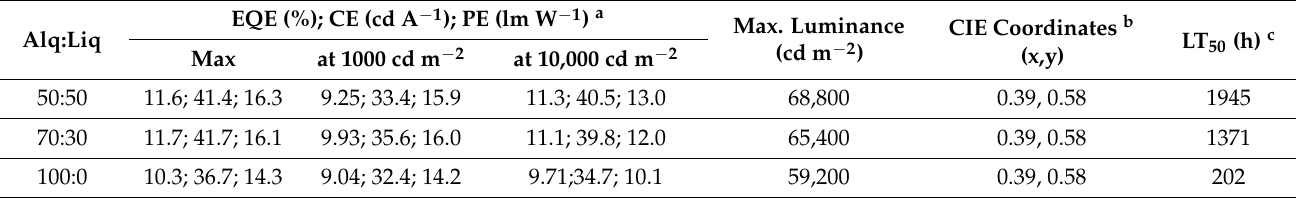
Table 1. Key performances of tetra-Pt-S-based PhOLEDs with different weight ratio of Alq 3 :Liq in ETL.